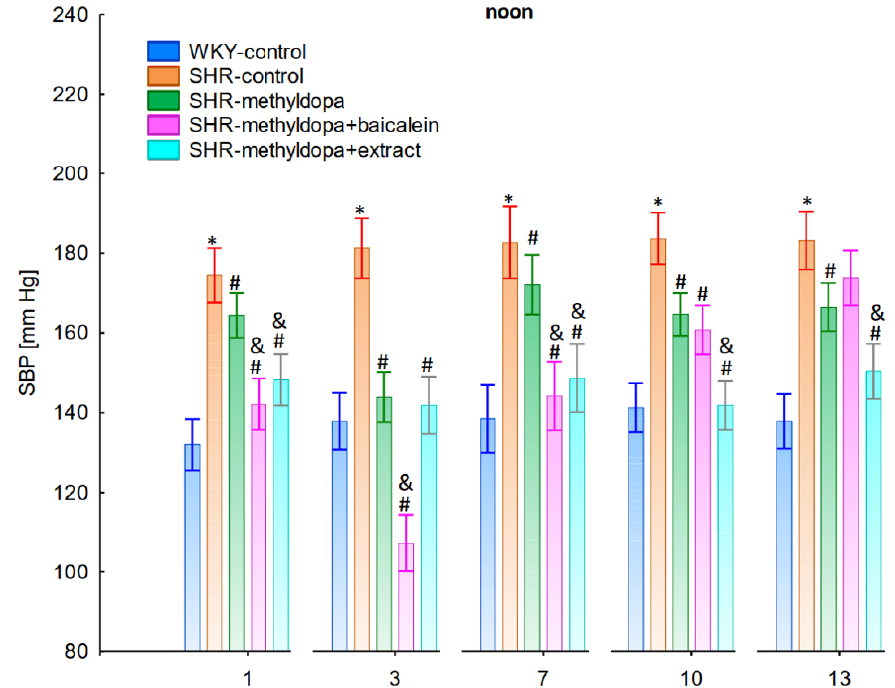
Figure 4. Influence of methyldopa and its combination with baicalein or extract from Scutellaria baicalensis roots on noon systolic blood pressure (SBP) in SHR pregnant rats. Legend: n = 10, mean ± SEM; * — vs. WKY control, p < 0.05; # — vs. SHR control, p < 0.05; & — vs. SHR-methyldopa, p < 0.05.